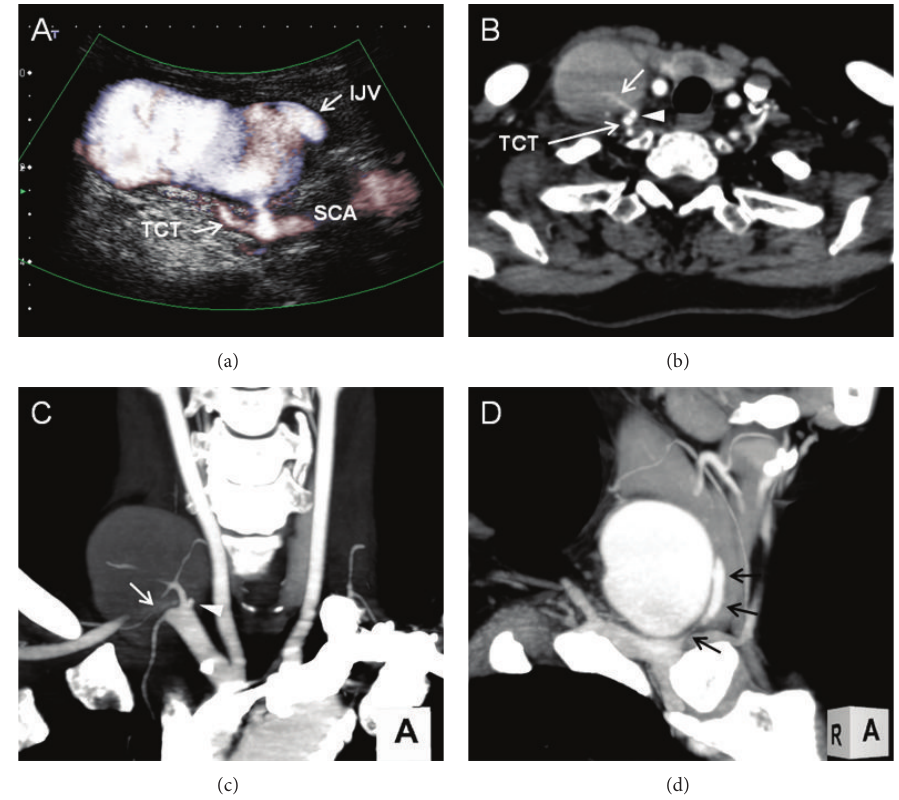
Figure 1: (a) Duplex ultrasound in the longitudinal plane at the level of the right supraclavicular fossa. The PsA communicated with the root of the thyrocervical trunk (TCT) with inner turbulent flow via the short, narrow neck. Continuity between the PsA and the internal jugular vein (IJV) was also noted. SCA: subclavian artery. (b) Contrast-enhanced computed tomography angiography showed a high-density-flow jet of contrast agent shunting from the TCT (arrow) into the aneurysmal sac via the short neck (arrowhead). (c) Maximum-intensity projection (MIP) image in the arterial phase clearly showed the anatomical relationship between the TCT and PsA neck (arrowhead). A flow jet within the PsA was also shown (arrow). (d) MIP image in the venous phase showed continuity between the aneurysmal sac and internal jugular vein